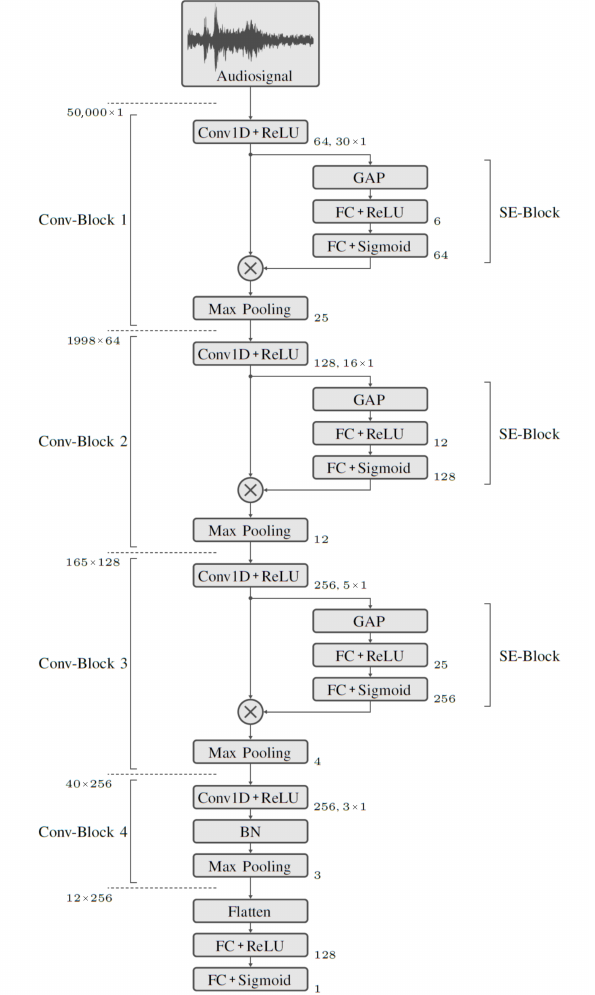
Figure 3. Network structure of the audio model with the applied operations. To the right of the operations, their set parameters can be seen, such as the number of neurons, filters and filter sizes. The size of the tensor, at the model input and at the output of each of the convolutional blocks, is shown on the left